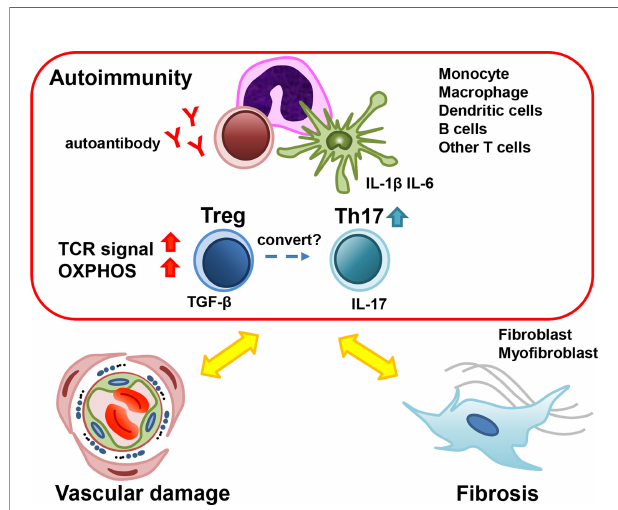
FIGURE 1 | The role of Treg in the pathogenesis of early SSc. Many types of cells contribute to the pathogenesis of early SSc. Treg cells secrete TGF- b , which promotes myo fi broblast activation and fi brosis. The dysfunction of Treg cells results in the development of autoimmunity and in fl ammation. Under the in fl ammatory condition, Treg could convert into Th17 and Th17 could promote in fl ammation and vasculopathy. SSc; systemic sclerosis, Treg; regulatory T cells, Th17; T- helper17 cells, TGF- b ; transforming growth factor- b